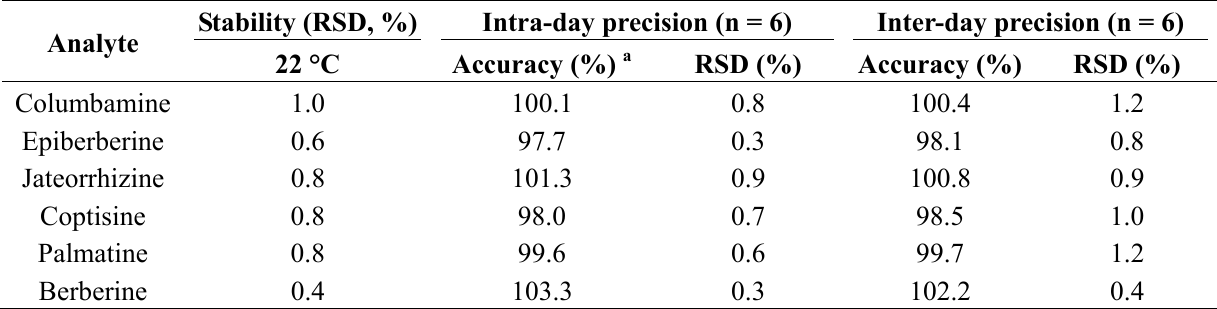
Table 3. Stability of the tested alkaloids, intra- and inter-day precision of the UPLC method. Analyte